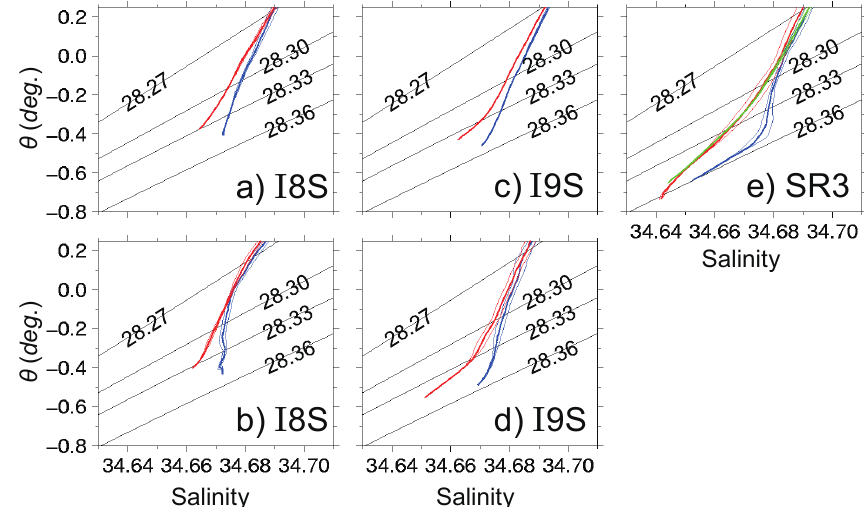
Fig. 3. Variations of θ - S curves for (a) I8S (46–60 ◦ S, the Australian-Antarctic Basin), (b) I8S (60–67 ◦ S, the PET), (c) I9S (50–61 ◦ S), (d) I9S (61–66 ◦ S) and (e) SR3. Data are averaged on the isopycnal surfaces. Means are shown by thick lines and one standard deviation envelopes are shown by thin lines (following Johnson et al., 2008). Blue lines are from the WHP occupations in the 1990s. Red lines in (e) are from repeat occupations in the year 2001, 2002, 2003 and green lines in (e) are from in the year 2008. All the red lines in other panels are from repeat occupations in the 2000s. Labeled black lines are contour of neutral density (kgm − 3